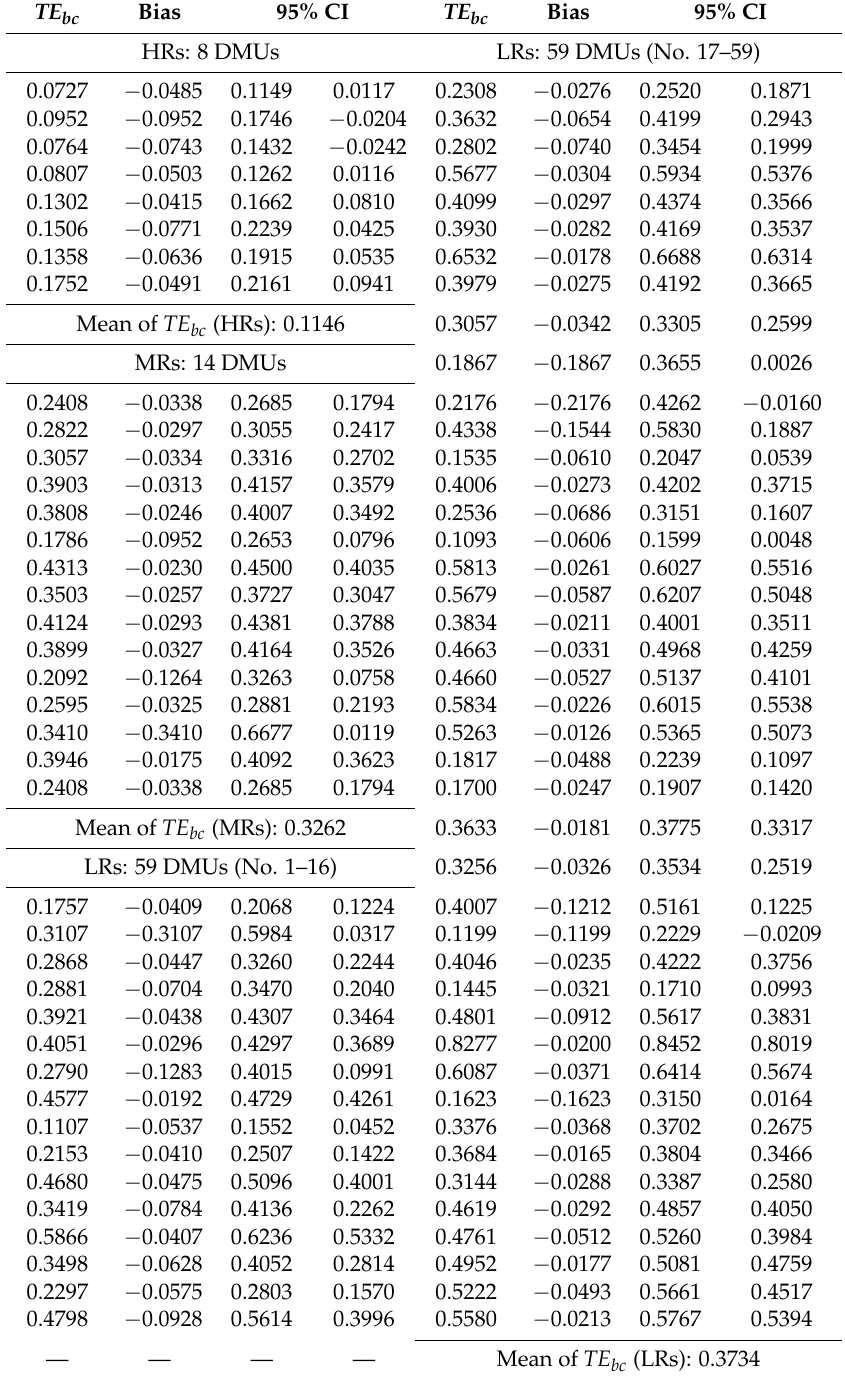
Table 3. Bias-corrected Technical Efficiency (TE) with Estimated 95% Confidence Intervals by